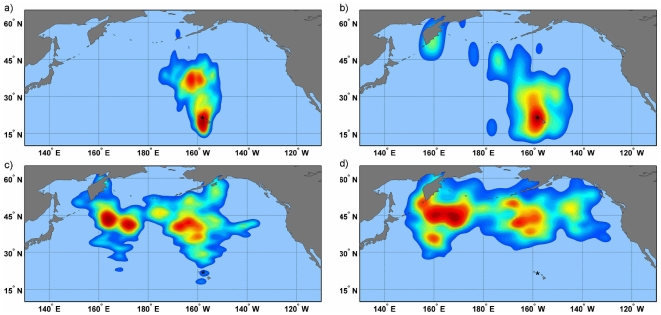
At-sea utilization distribution kernels for Laysan albatross foraging from Oahu.Kernels increase in 2% increments from 2%–95% with increasingly warmer tones represent the highest utilization distribution (2%). Kernels are shown for the a) incubation b) chick guard c) post-guard and d) non-breeding stages. Colony location is indicated by an asterisk.